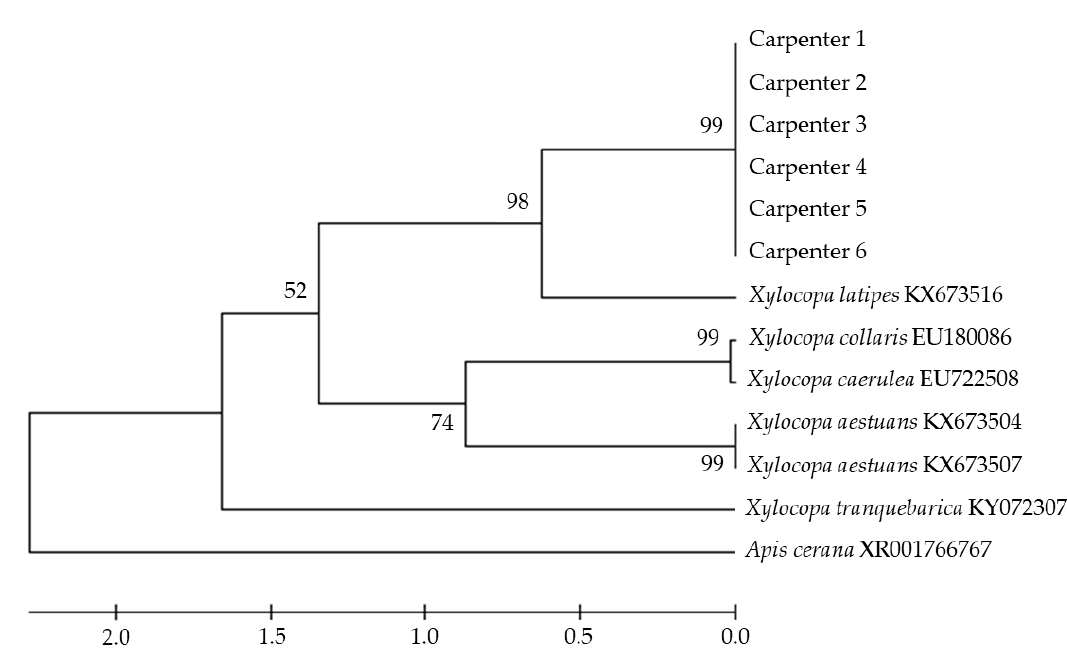
Figure 2. Phylogenetic tree of Xylocopa spp. COI gene sequences and closely related reference sequences were constructed by unweighted pairs group method with arithmetic mean (UPGMA). Bootstrap values (based on 1000 resamplings) higher than 50 were indicated at the nodes.